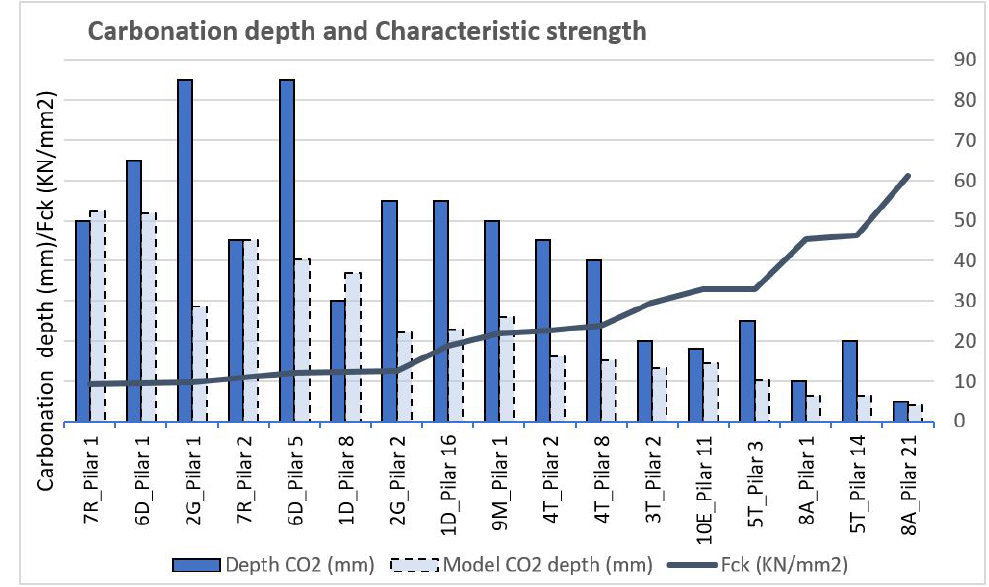
Figure 11. Carbonation depth and characteristic strength. Laboratory data and model data.